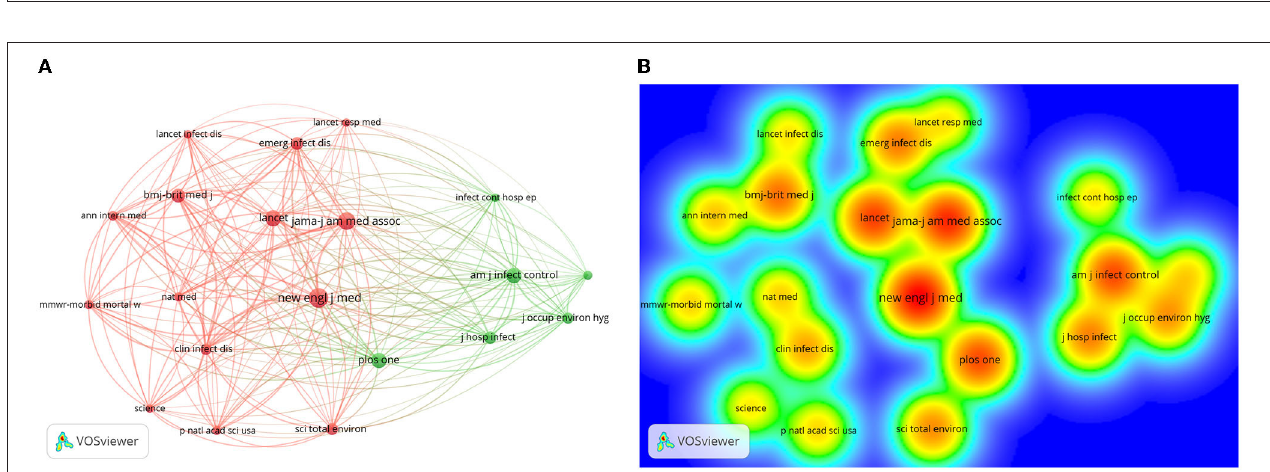
FIGURE 3 | Visualization mapping of co-citation cited sources. ( A) Network visualization map; (B) density visualization map. A minimum number of citations of a source: 200. Of the 11,711 sources, 20 sources met the threshold. For each of the 20 sources, the TLS with other sources was calculated. The sources with the greatest TLS were